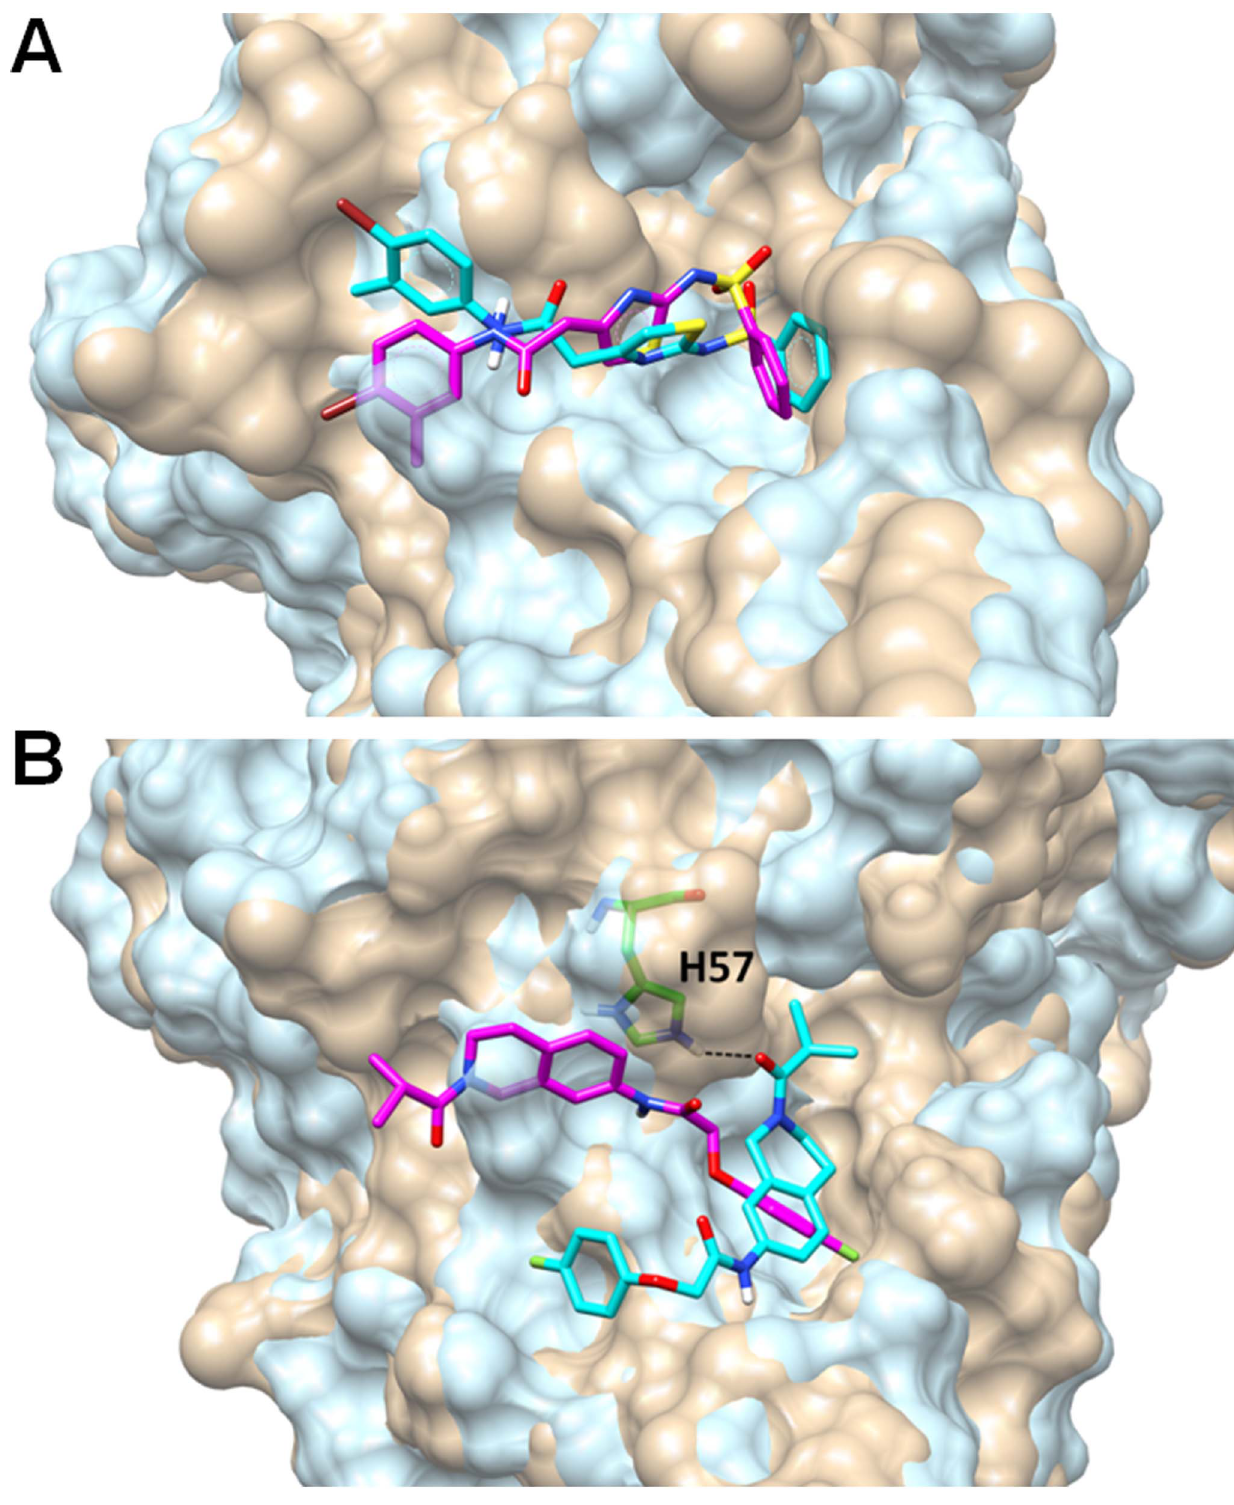
Figure 5. Comparison of the docking poses with NS3 proteases from sub-genotype 1a and 1b. ( A ) Docking poses of 12 colored in pink with the sub-genotype 1b NS3 protease (colored in tan). Compound 12 is colored in cyan when it was docked with the sub-genotype 1a NS3 protease (colored in cyan). ( B ) Docking poses of compound 13 colored in cyan with sub-genotype 1a (also colored in cyan). The histidine 57 residue is shown in green, and a hydrogen bond with 13 is shown as a black dotted line. Compound 13 is colored in pink when it was docked with sub- genotype 1b (colored in tan) NS3 proteases. Figure prepared with Chimera v1.6.1, UCSF, 2012 [37].